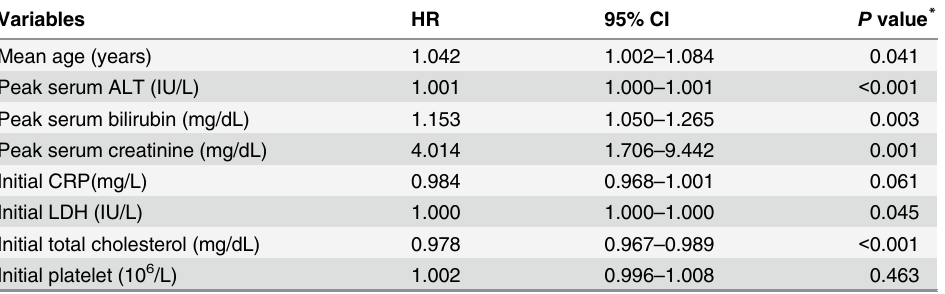
Table 2. Multivariate analysis of predictive factors associated with severe acute hepatitis A.